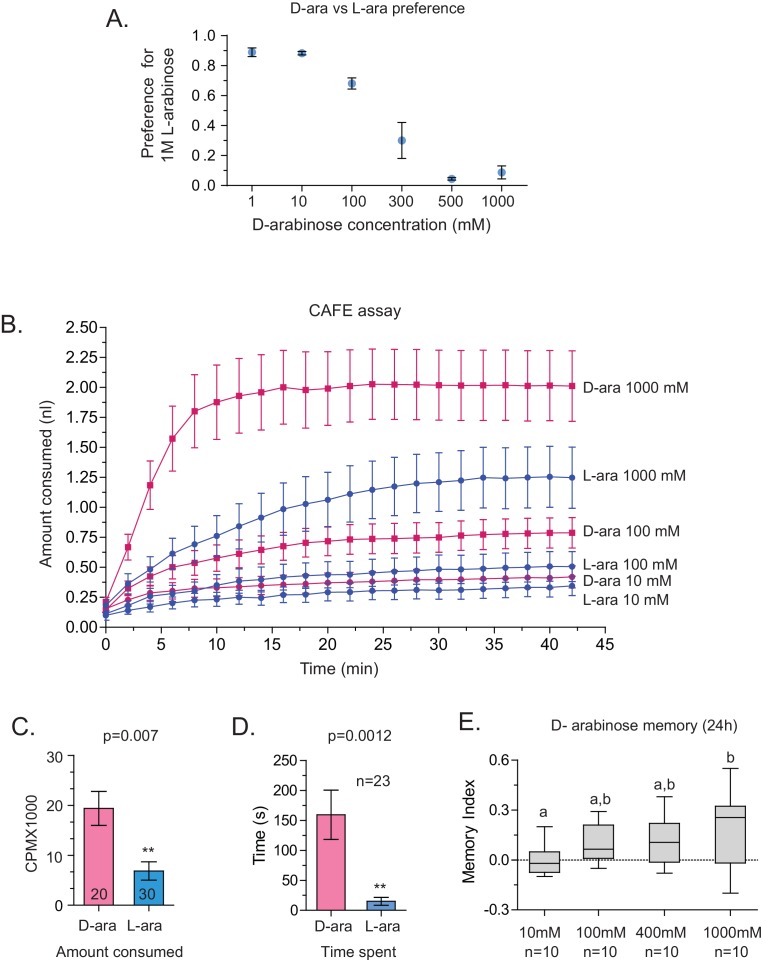
Although both are sweet, D-arabinose is preferred over L-arabinose.(A) At equal concentrations, flies overwhelmingly prefer D-arabinose to L-arabinose; the preference begins to shift when L-arabinose is ≥3 times more concentrated than D-arabinose. (B) CAFÉ assay quantifying flies’ intake of D- and L-arabinose across a range of concetrations. (C) In 5 min, flies consume more radioactive [32]P-mixed D-arabinose than radioactive [32]P-mixed L-arabinose during two-choice tests when either sugar is tested separately against water. (D) Single flies monitored by video spend more time on 1 M D-arabinose than 1 M L-arabinose when the two are presented side-by-side. (E) The greater the concentration of D-arabinose, the better the memory score. This suggests that the flies are not eating so much D-arabinose that they become sick, and would otherwise remember if not for eating large amounts of sugar. Memory does not improve at lower concentrations. For multiple samples, one way ANOVA with Tukey’s multiple comparisons test was performed, and significant differences (p<0.05) are denoted by different letters. Results with error bars are means ± s.e.m. ns, not significant. *≤0.01, **≤0.001 and ***≤0.0001.